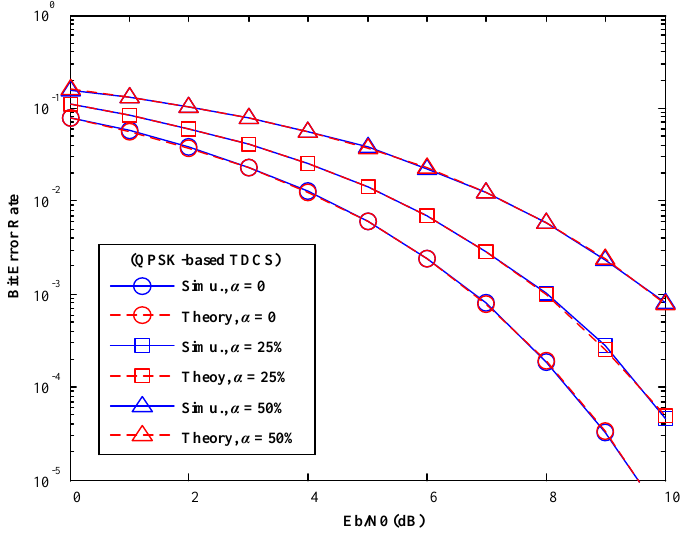
Figure 8. BER performance of TDCS-QPSK in AWGN channels (various mismatch factor α).